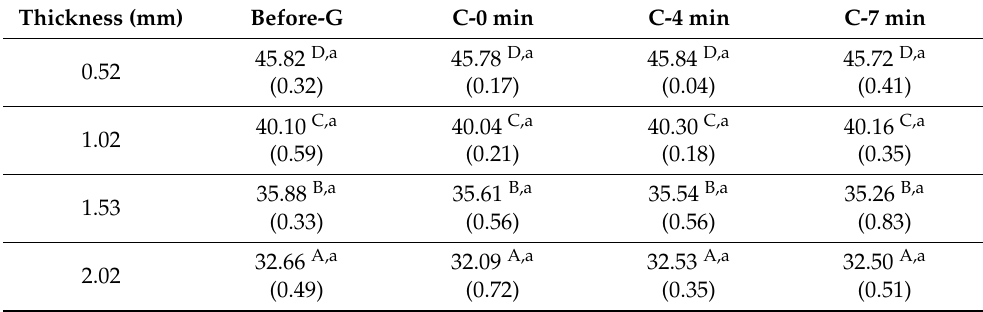
Table 4. AT as a function of cooling rate for specimens with various thicknesses (mean ± SD).